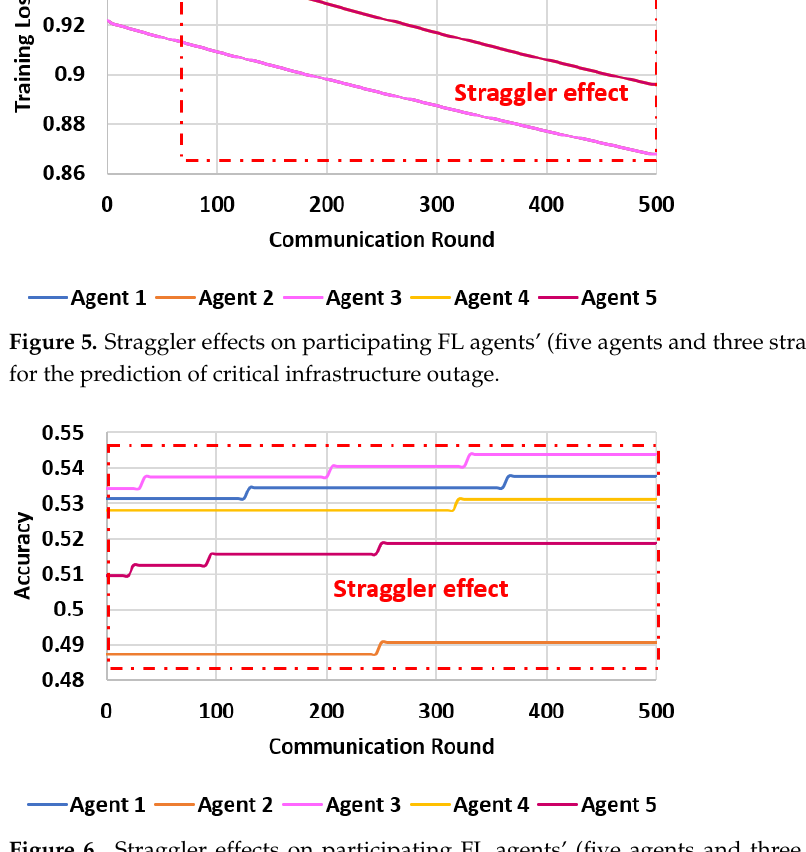
Figure 6. Straggler effects on participating FL agents’ (five agents and three stragglers) model accuracy for the prediction of critical infrastructure